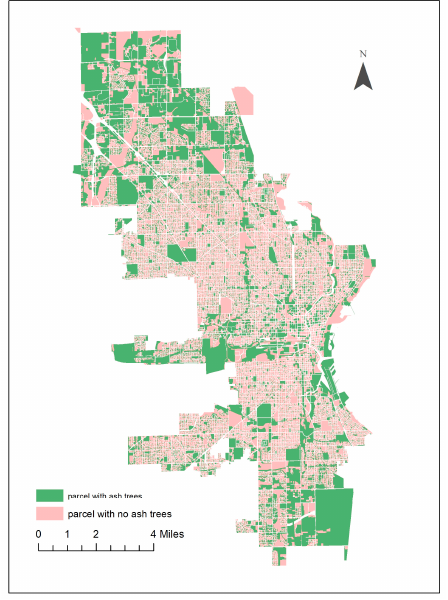
Figure 1. Parcels with ash trees in Milwaukee.